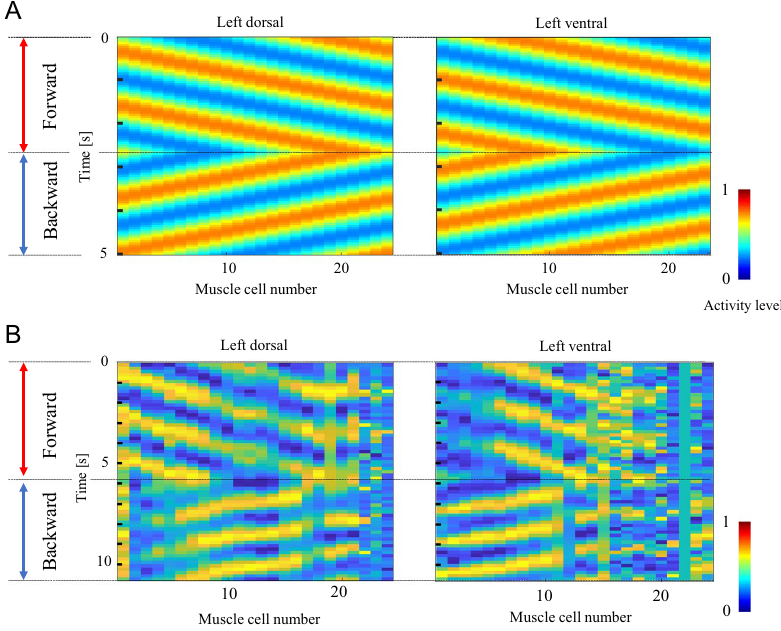
Figure 4. Teacher data for muscles. ( A ) Teacher data generated by Eqs. (9)–(11). ( B ) Teacher data generated using the measured muscle activity. The red arrows represent the time duration of forward movement, and the blue arrows represent the time duration of backward movement. The output switches between forward and backward movement at the predetermined time. The x-axis represents the muscle cell number, indexed from head to tail, the y-axis represents time, and the color represents the teacher data for the muscle activation level. The same teacher data are used for the right side of the body-wall